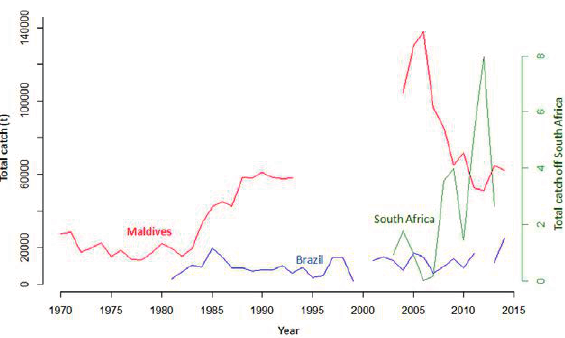
Fig. 2. – Annual total catches in t for BR, MA and SA skipjack fisheries.